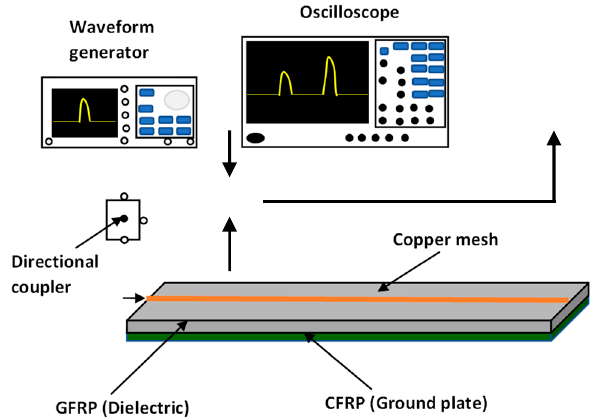
Figure 6. Time -domain reflectometry (TDR) based on the microwave transmission line